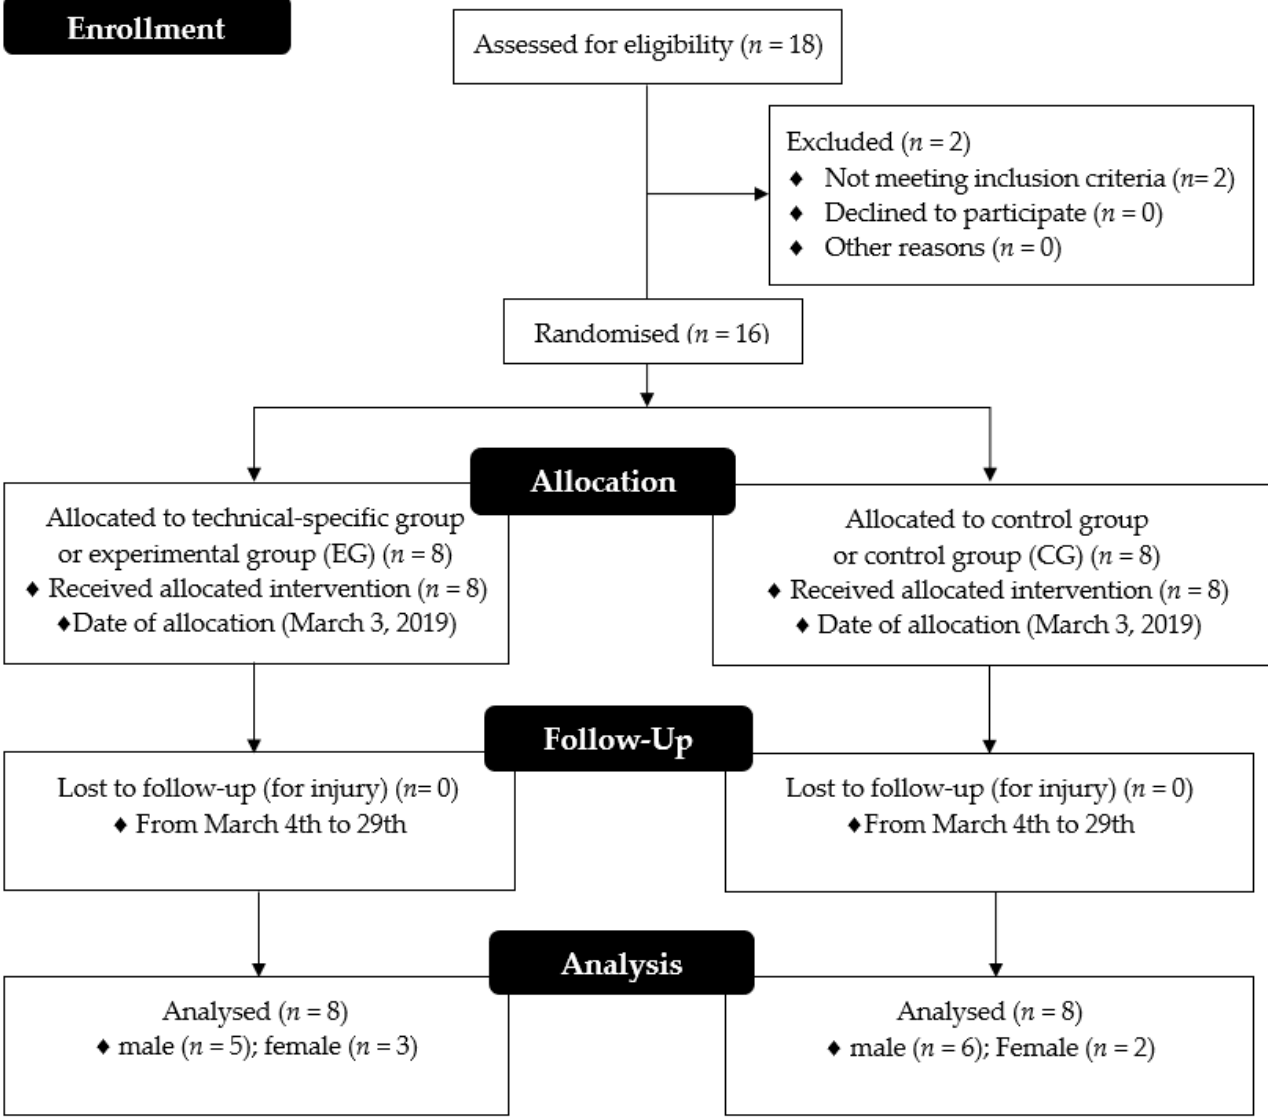
Figure 1. Participants flow.